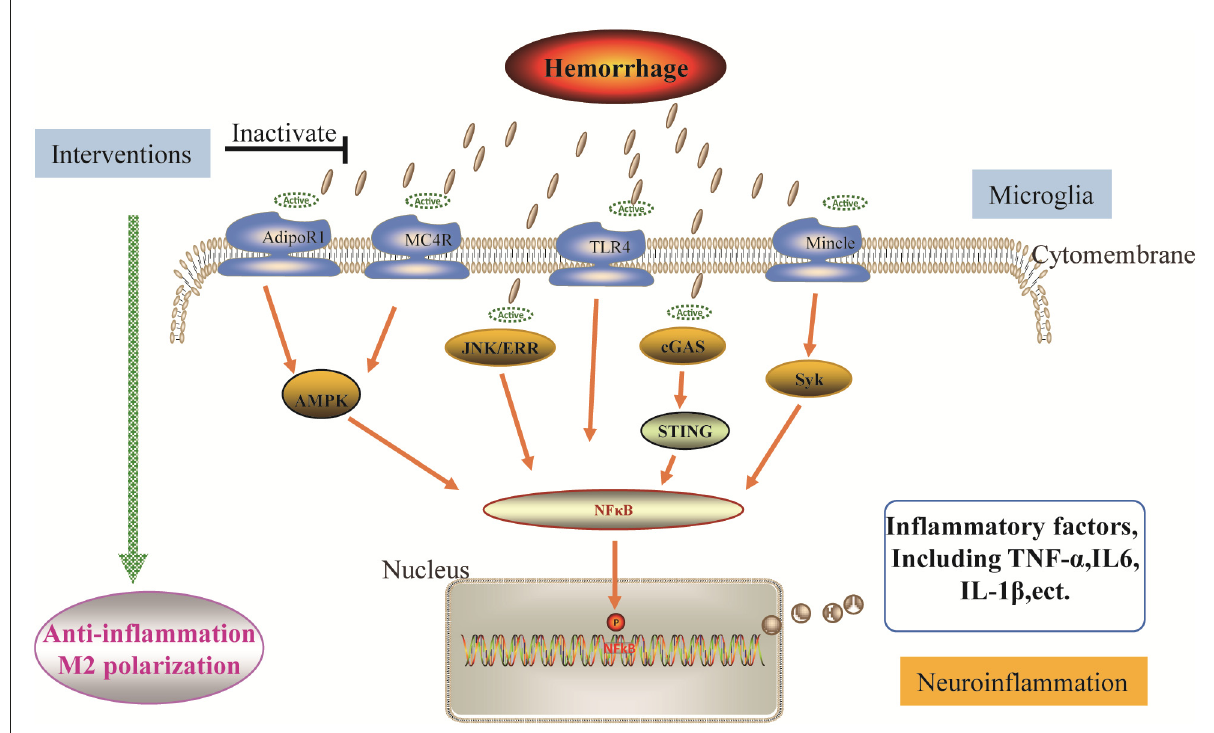
FIGURE2 Potential interventions for the neuroinflammation following ICH. Interventions induce the polarization of pro-inflammatory microglia towards the anti inflammatory phenotype through different mechanisms, exerting beneficial effects. The mechanisms associated with ICH include the AdipoR1/MC4R-AMPK pathway, JNK-ERR pathway, TLR4 pathway, cGAS-STING pathway, and Mincle-Syk pathway, activation of which enhances the microglial neuroinflammation. After the corresponding intervention inhibits these pathways, the Ml phenotype shifts to the M2 phenotype of